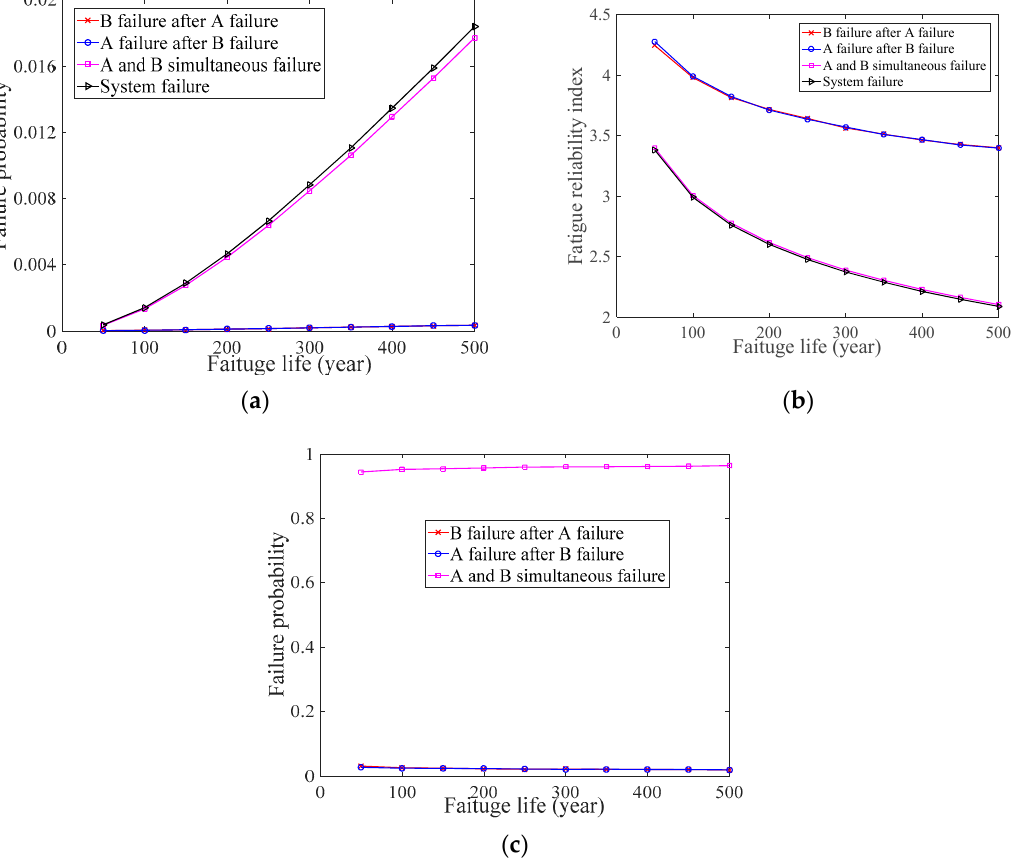
Figure 2. Numerical case study 1. ( a ) Fatigue probability of the welds and system; ( b ) Fatigue reliability index of the welds and system; ( c ) Bayesian inference.